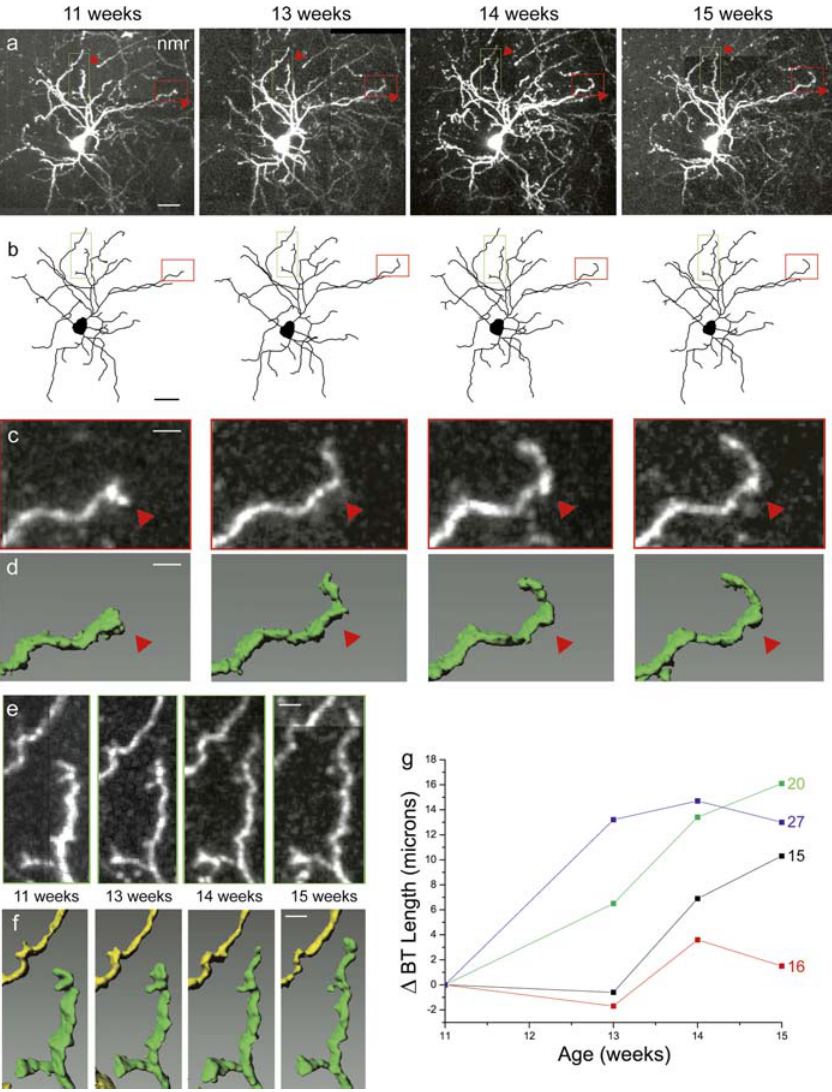
Figure 3. Dendritic Growth in Multiple Branches of a Non-Pyramidal Neuron (A) MZPs near the cell body of the ( ; 118- l m deep) non-pyramidal cell ‘‘ nmr ’’ acquired over 4 wk. Two examples of dendritic branch growth are indicated by red arrowheads. (B) Two-dimensional projections of three-dimensional skeletal reconstructions of the non-pyramidal neuron ‘‘ nmr. ’’ (C) High-magnification view of one growing branch tip (#20) (red box in [A and B]). Red arrowhead marks the approximate distal end of the branch tip at 11 wk. (D) Three-dimensional isosurface reconstructions of branch tips in (C). (E) High-magnification view of branch tip #15 (green box in [A and B]). (F) Three-dimensional isosurface reconstructions of branch tips in (E). (G) Plot of change in BTL of dynamic branch tips as a function of age. Number to the right denotes branch tip number. Scale bars: (A and B), 25 l m; (B–F), 5 l